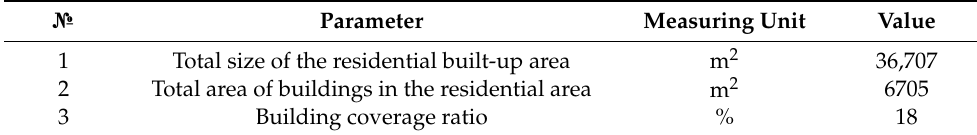
Table 4. The main parameters of the territory for the control experiment.